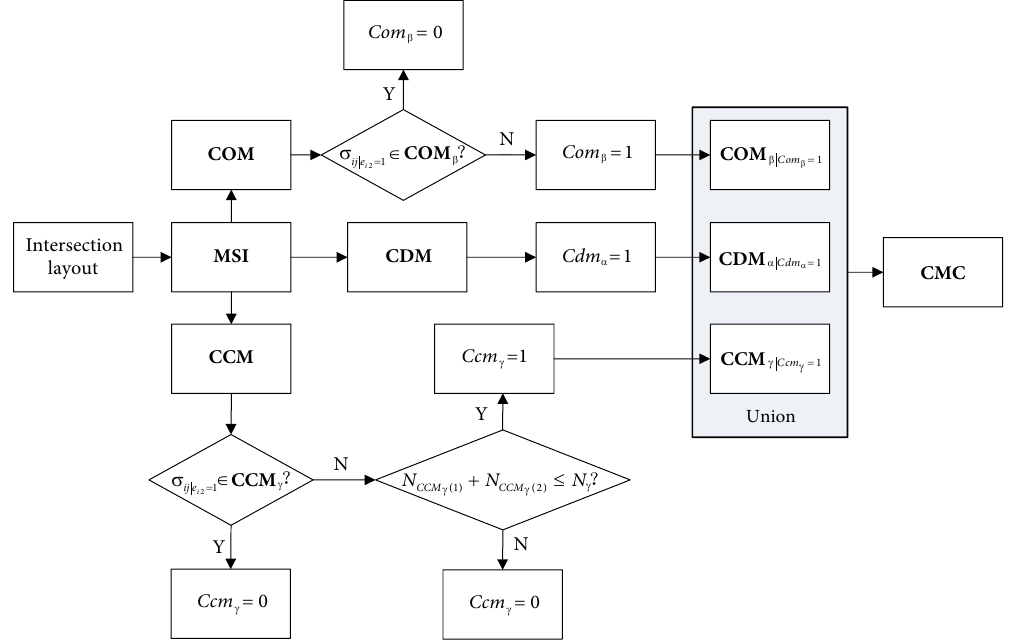
Figure 4. Determination process of set